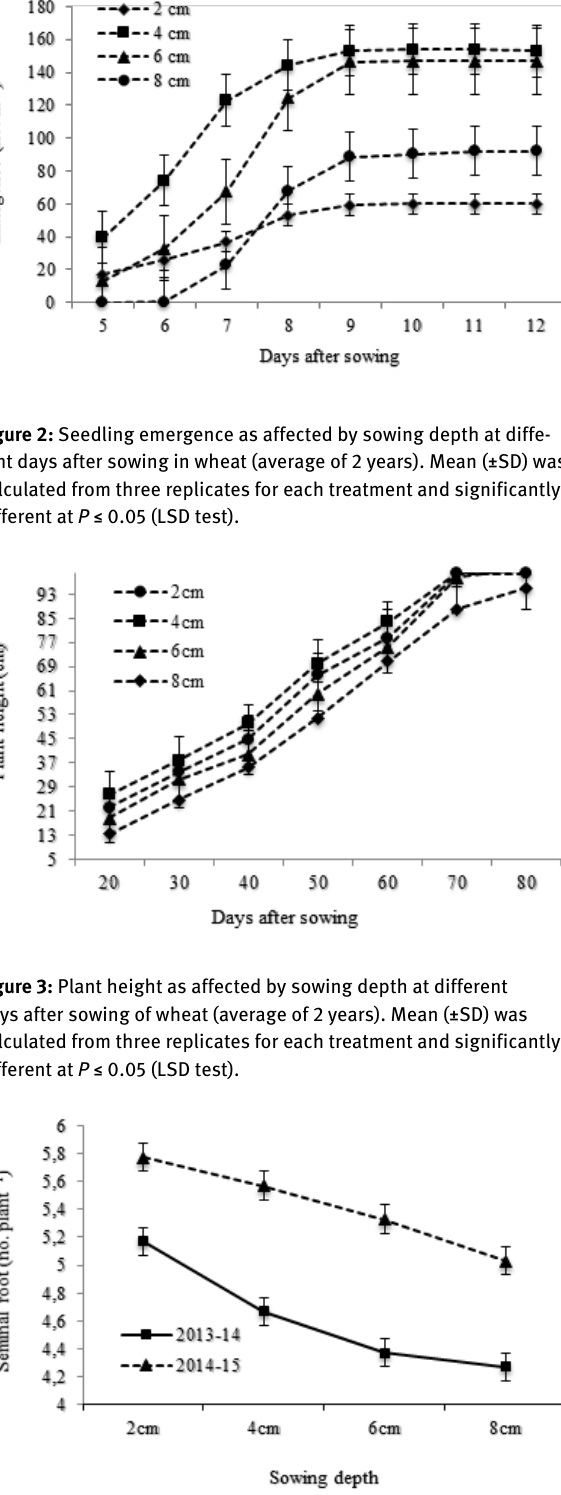
Figure 4: Number of seminal roots as affected by sowing depth of wheat recorded at 10 DAS. Mean (±SD) was calculated from three replicates for each treatment and significantly different at P ≤ 0.05 (LSD